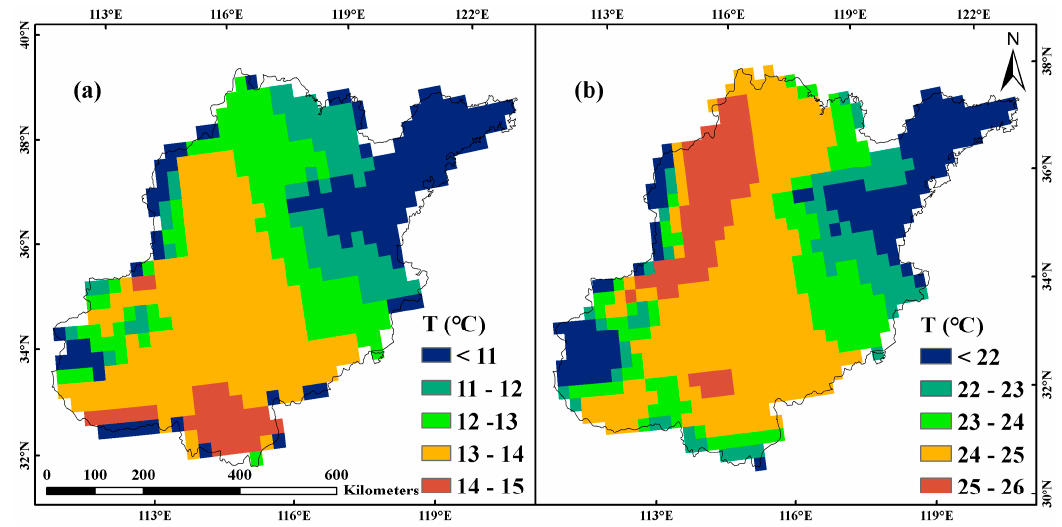
Figure 6. The patterns of two-month mean temperature (T) in March–April ( a ) and May–June ( b ) across the NCP during 2003–2018.